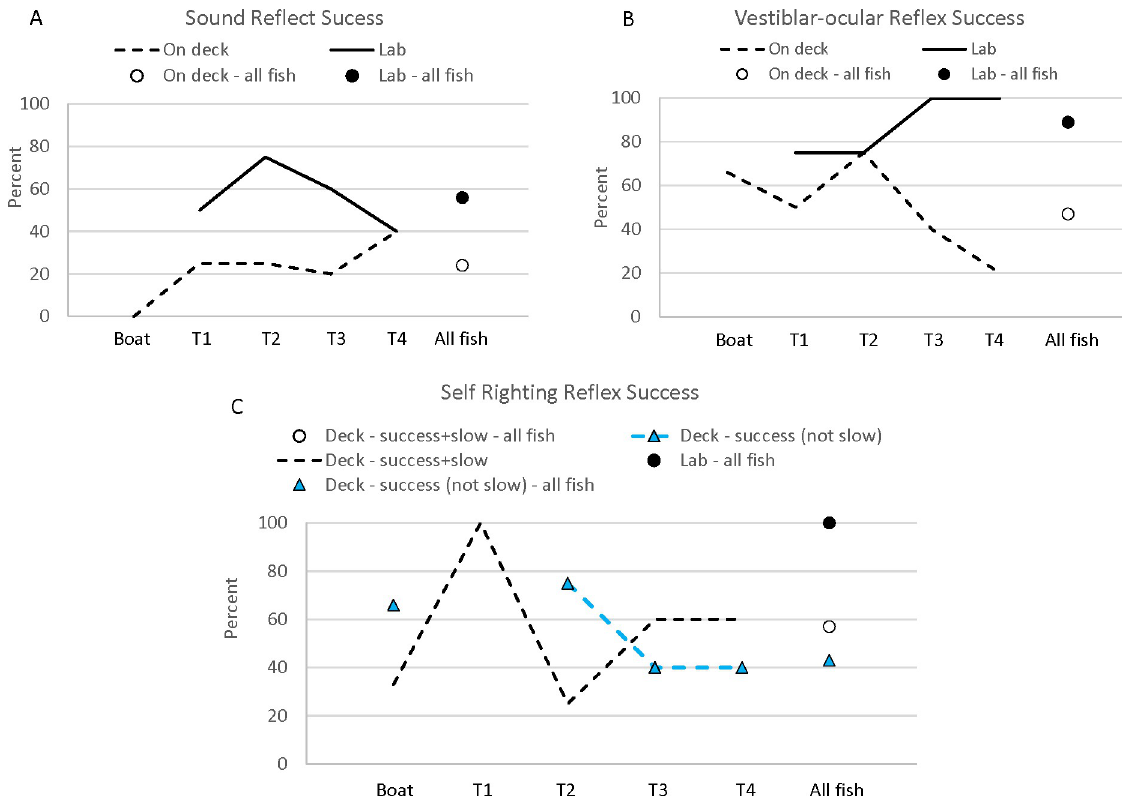
Fig 1. The percent of shortspine thornyhead that successfully performed each reflex test, or performed them slowly (for self-righting), on deck and 10–42 days later in the laboratory. Fish were tested in the laboratory (“Lab”) or immediately after capture (“On deck”). “On deck” reflex tests are presented for fish euthanized at each time period (T), where the reflex result is “On-deck” and not at the respective time period. Holding time periods included: 10–11 days after capture (T1), 17–19 days (T2), 28 days (T3), or 42 days (T4). The sample size of fish tested for reflexes and subsequently euthanized were: boat = 3, T1 = 4, T2 = 4, T3 = 5, T5 = 5. Overall, there were 21 fish tested on deck (“On deck—all fish”), which included the18 fish transported and held in the laboratory (“Lab–all fish”).